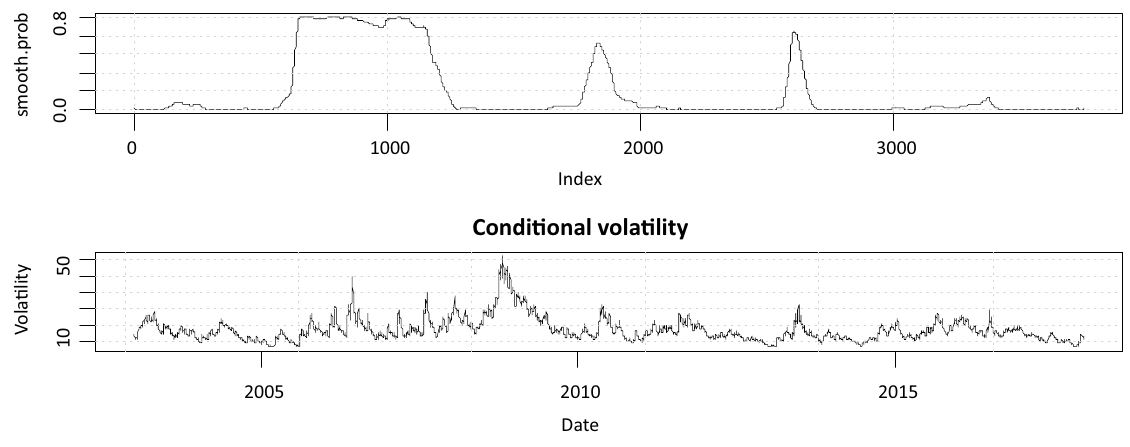
Figure 5. The smoothed probabilities of the high volatility